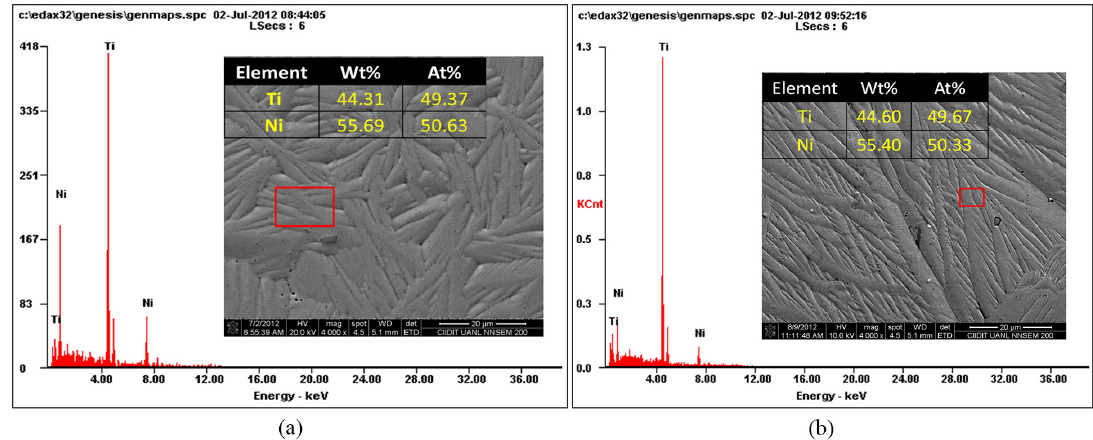
Figure 4. Energy dispersive spectroscopy (EDS) results for samples submitted to (a) HT1-24h and (b)